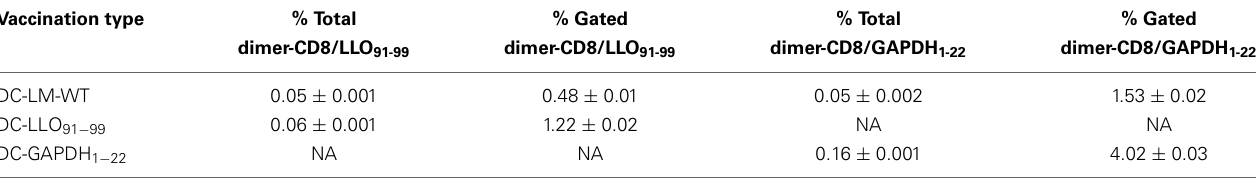
Table 3 | Frequencies of LLO 91 − 99 - and GAPDH 1 − 22 -specific CD8 + T cells induced by DC vaccines. Vaccination